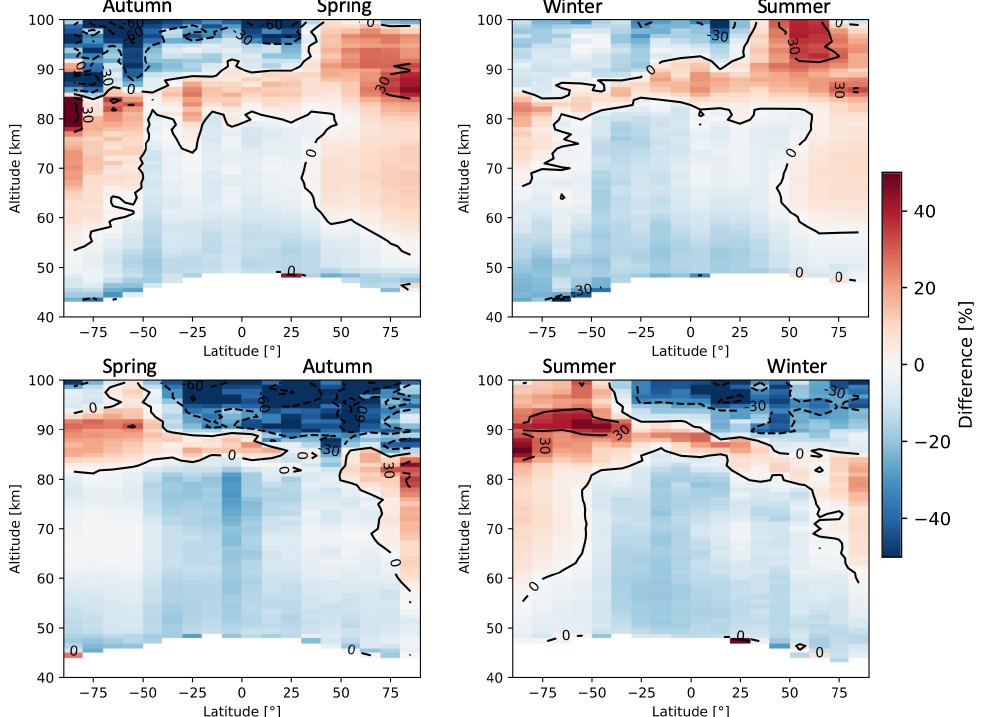
Figure A5. Seasonal zonal means of H 2 O FM13 SMR v3.0–v2.1 relative differences averaged over the whole time period between February 2001 and April 2019. The seasons are intended as astronomical seasons, i.e. each starting at the respective solstice or equinox.